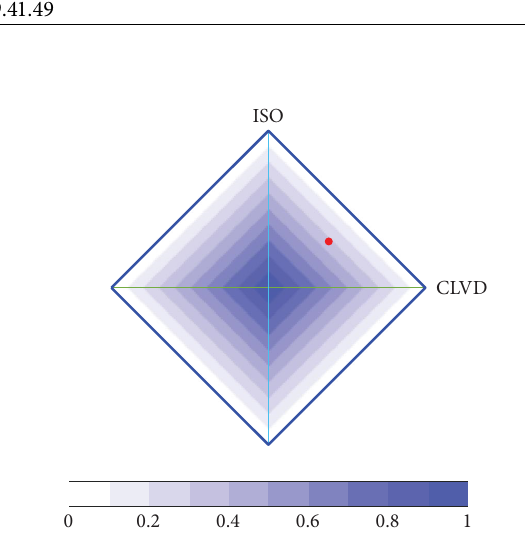
Figure 14: Te focal mechanism solution results of the strong mine tremor on November 30, 2020, at